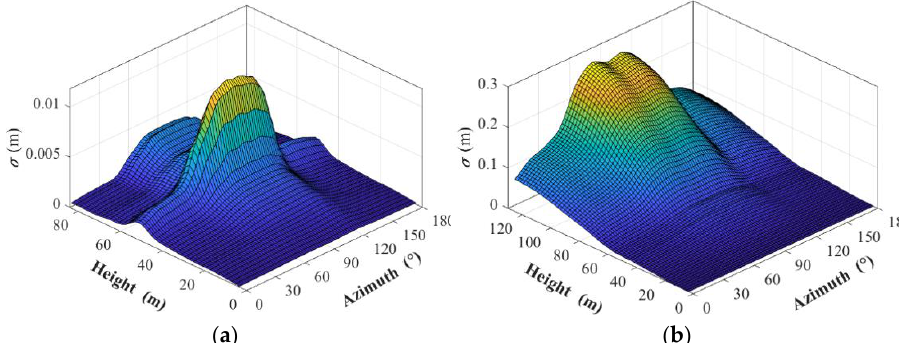
Figure 19. RMS of deformation of the quayside cranes: ( a ) boom-down state; and ( b ) boom-up state.